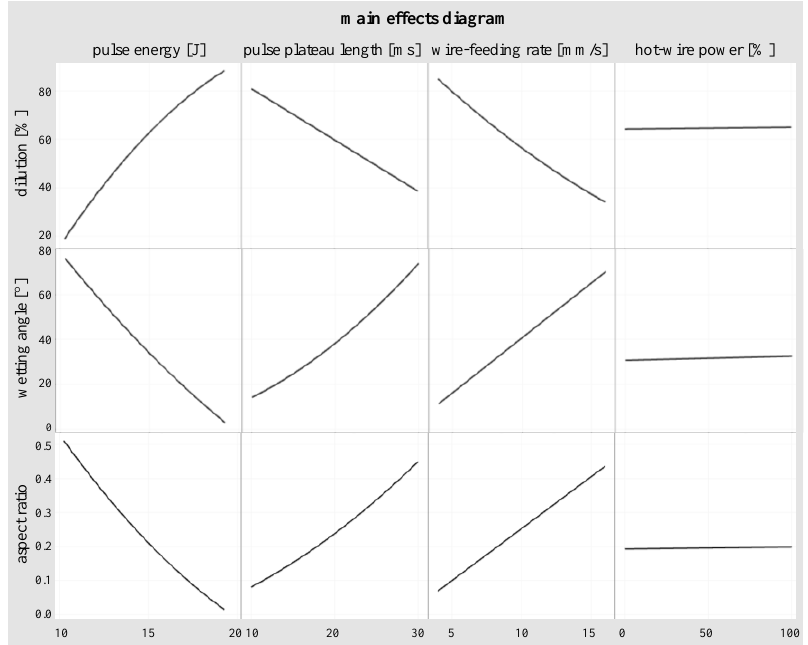
Figure 18. Main effects diagram representing the correlation between objectives and predictor Figure 18. Main e ff ects diagram representing the correlation between objectives and predictor variables.